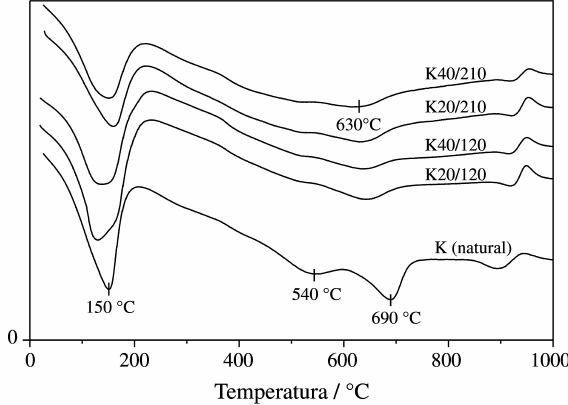
Figura 1. Curvas DTA das amostras natural e ativadas.